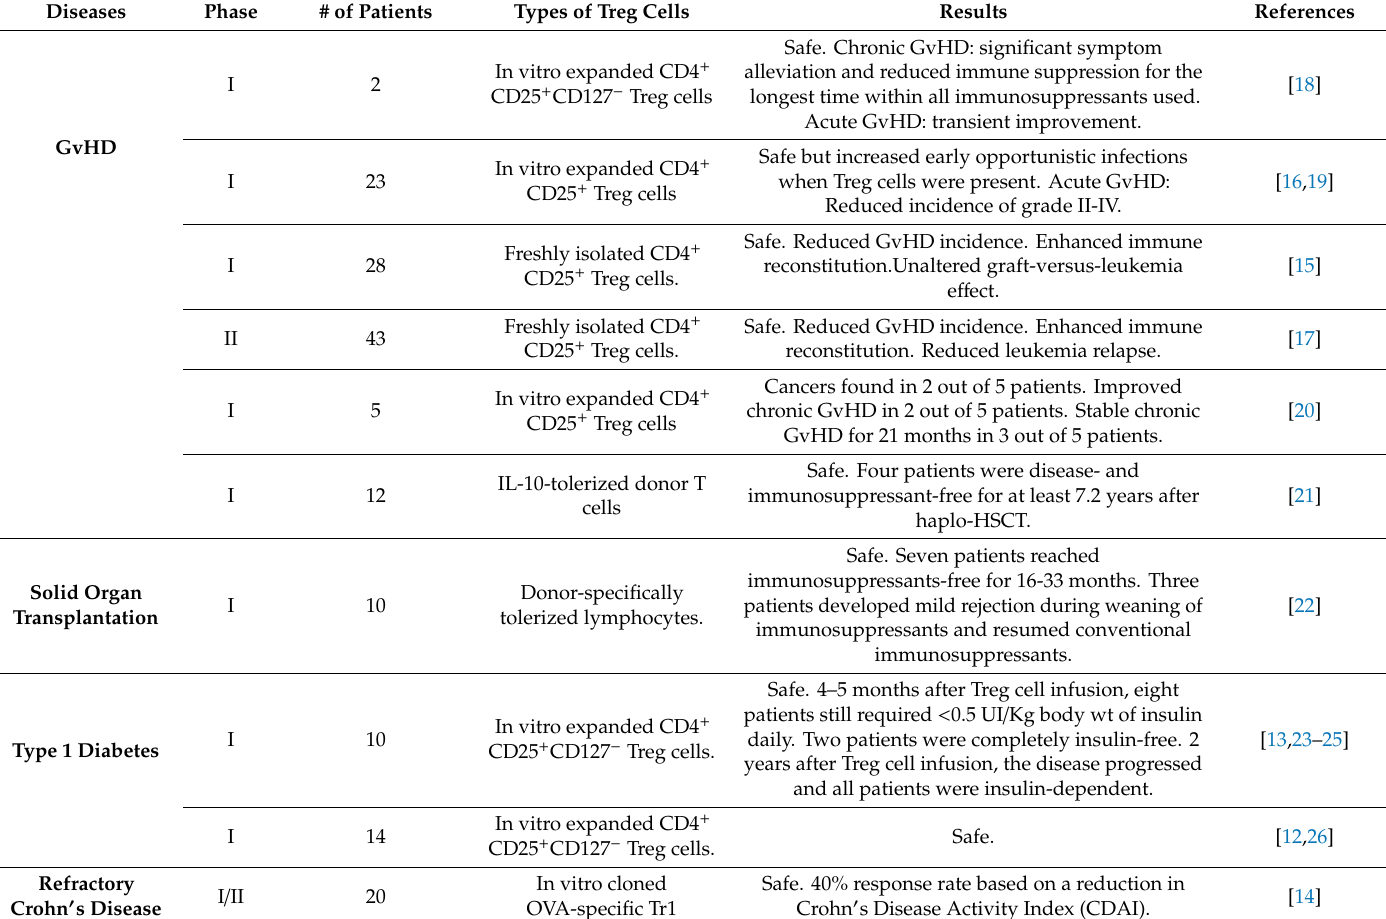
Table 1. Published clinical trials of Treg